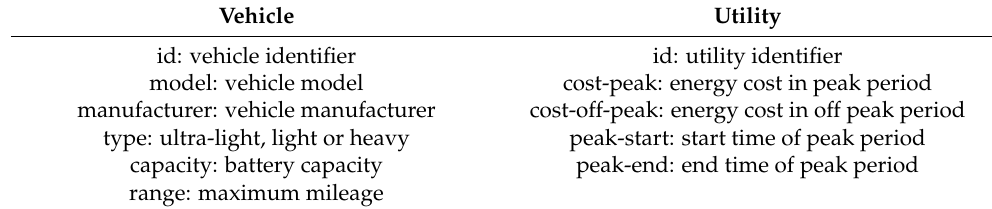
Table 2. External data attributes.